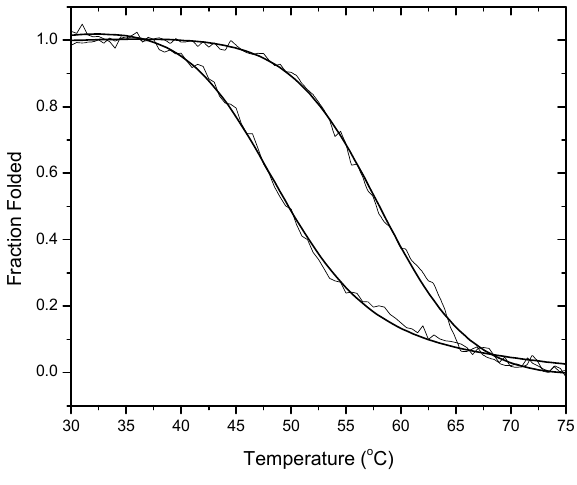
Figure 2. Optically detected fractional thermal denaturation of the DNA aptamer